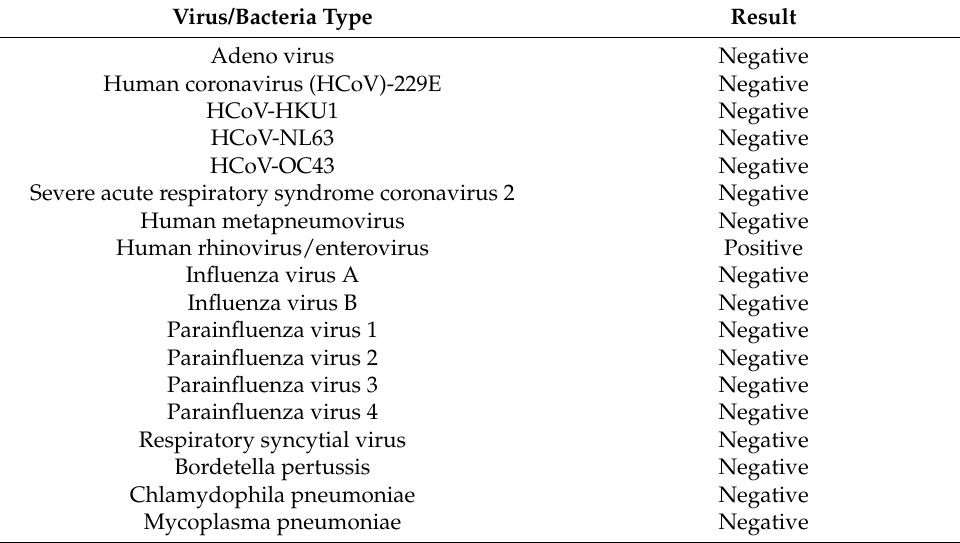
Table 1. Multiplex polymerase chain reaction results.